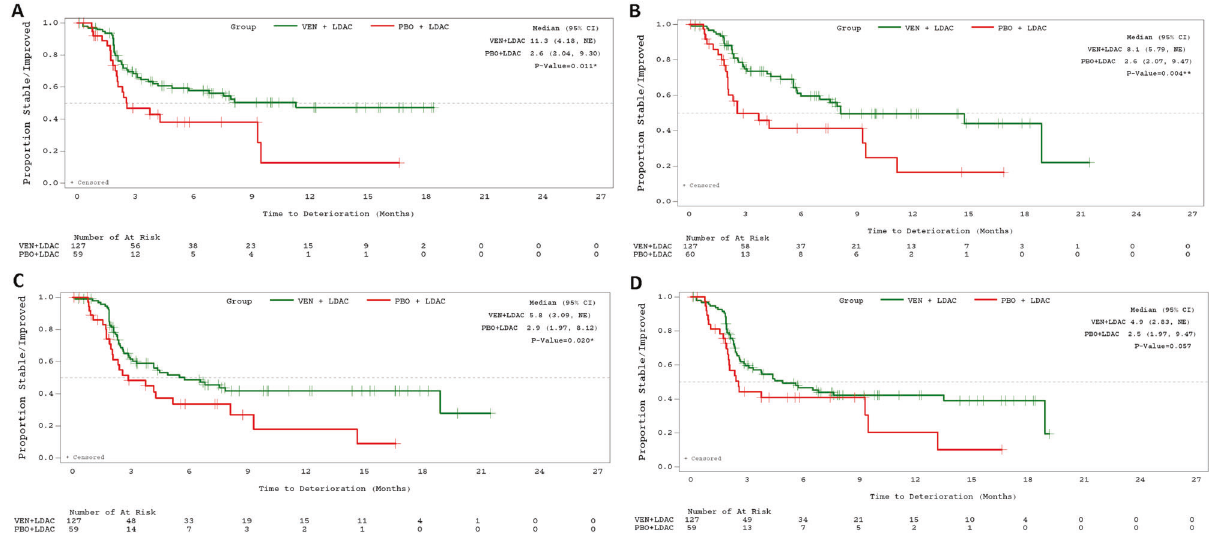
Fig. 2 Time to deterioration of PROs for LDAC based patients. Time to deterioration in EORTC GHS/QoL ( A ), PROMIS Fatigue ( B ), EORTC PF ( C ), and Health Status (EQ-5D-5L) VAS ( D ), VEN + LDAC versus PBO + LDAC. Time to deterioration thresholds for EORTC-QLQ-C30, EQ-5D-5L VAS, and PROMIS Fatigue are ≥ 10, 7, or 5 points, respectively. Time to deterioration analyses were conducted for all patients in the full dataset with available data on ≥ 1 PRO measures from baseline to the given assessment ( N = VEN + LDAC: 127, 127, 127, and 127; and PBO + LDAC: 59, 60, 59, and 59 for EORTC GHS/QoL, fatigue, PF, and health status VAS, respectively). CI con fi dence interval, EORTC QLQ-C30 European Organization for Research and Treatment of Cancer quality of life questionnaire, EQ-5D-5L EuroQoL 5-Dimension 5-Level, GHS global health status, LDAC low-dose cytarabine, NE not estimable, PBO placebo, PF physical functioning, PROMIS Patient-Reported Outcomes Measurement Information System, QoL quality of life, VAS visual analog scale, VEN